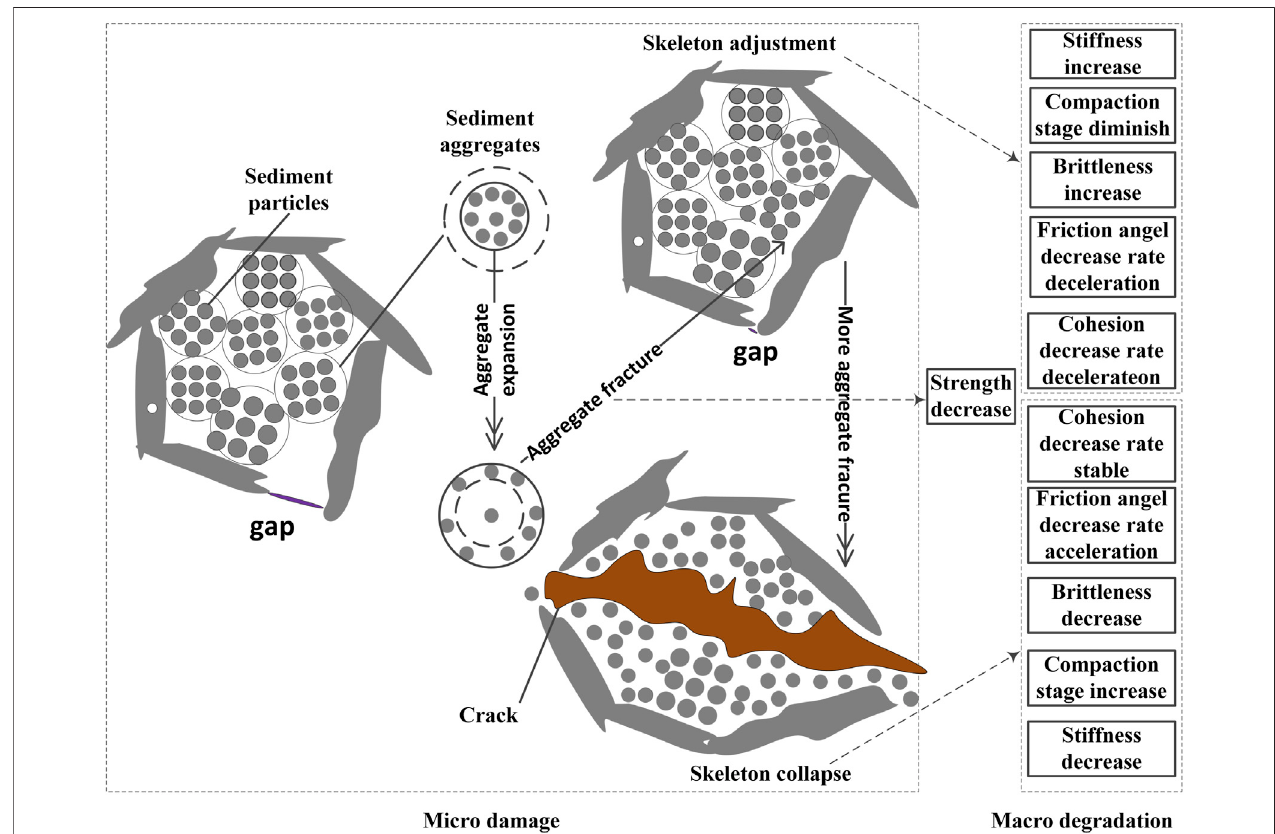
FIGURE 11 | Damage model of S/S sediments by